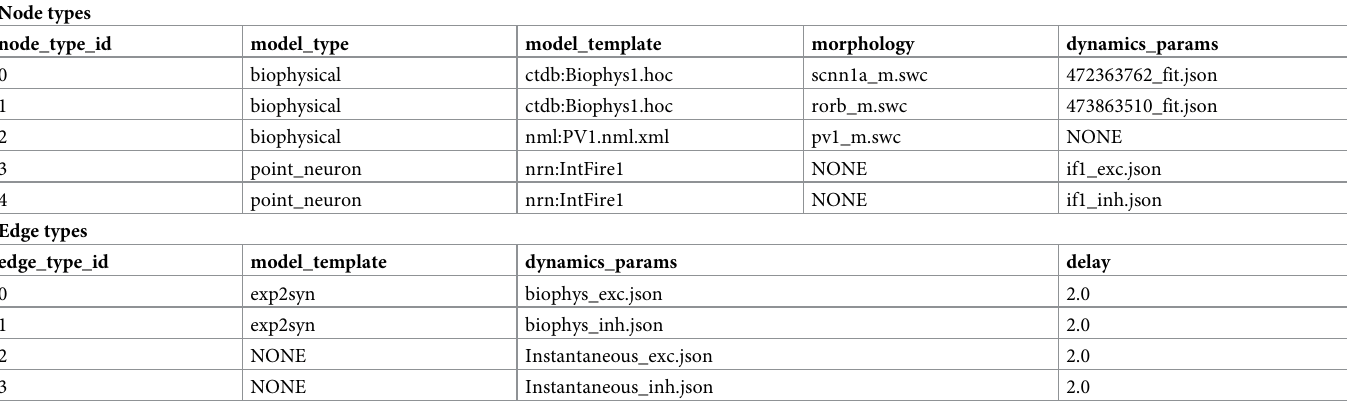
Table 1. Examples of “node types” and “edge types”. In a network model, all individual nodes belonging to a particular node type share the respective attributes, and likewise all edges belonging to the same edge type share attributes of that type. Node